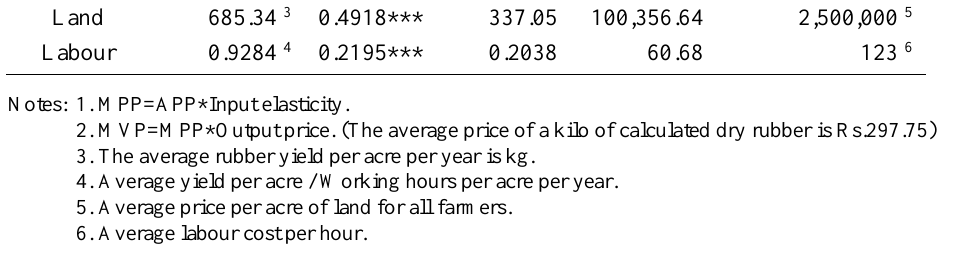
Table 07: MPP, MVP and UFC